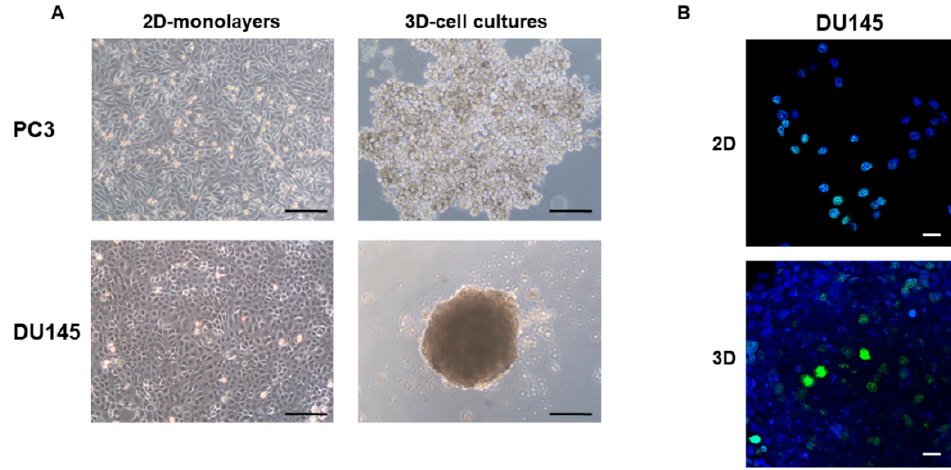
Figure 1. Morphology of prostate cancer (PCa) cells grown in 2D-monolayers and 3D cell cultures. ( A ) Micrograph at the inverted microscope showing the epithelial morphology of PC3 and DU145 cells grown in 2D-monolayers and 3D cell cultures after 10 days. Original magnification: 10×. ( B ) Confocal microscopy showing Ki-67 expression in DU145 grown in 2D-monolayer and 3D-spheroid. Original magnification: 40×. Blue: DAPI; green: Ki-67. Bar: 200 µm ( A ), 20 µm ( B ).